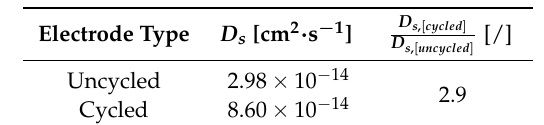
Table 6. Diffusion coefficients in uncycled and cycled electrodes at 3.71 V determined by GITT and their diffusivity